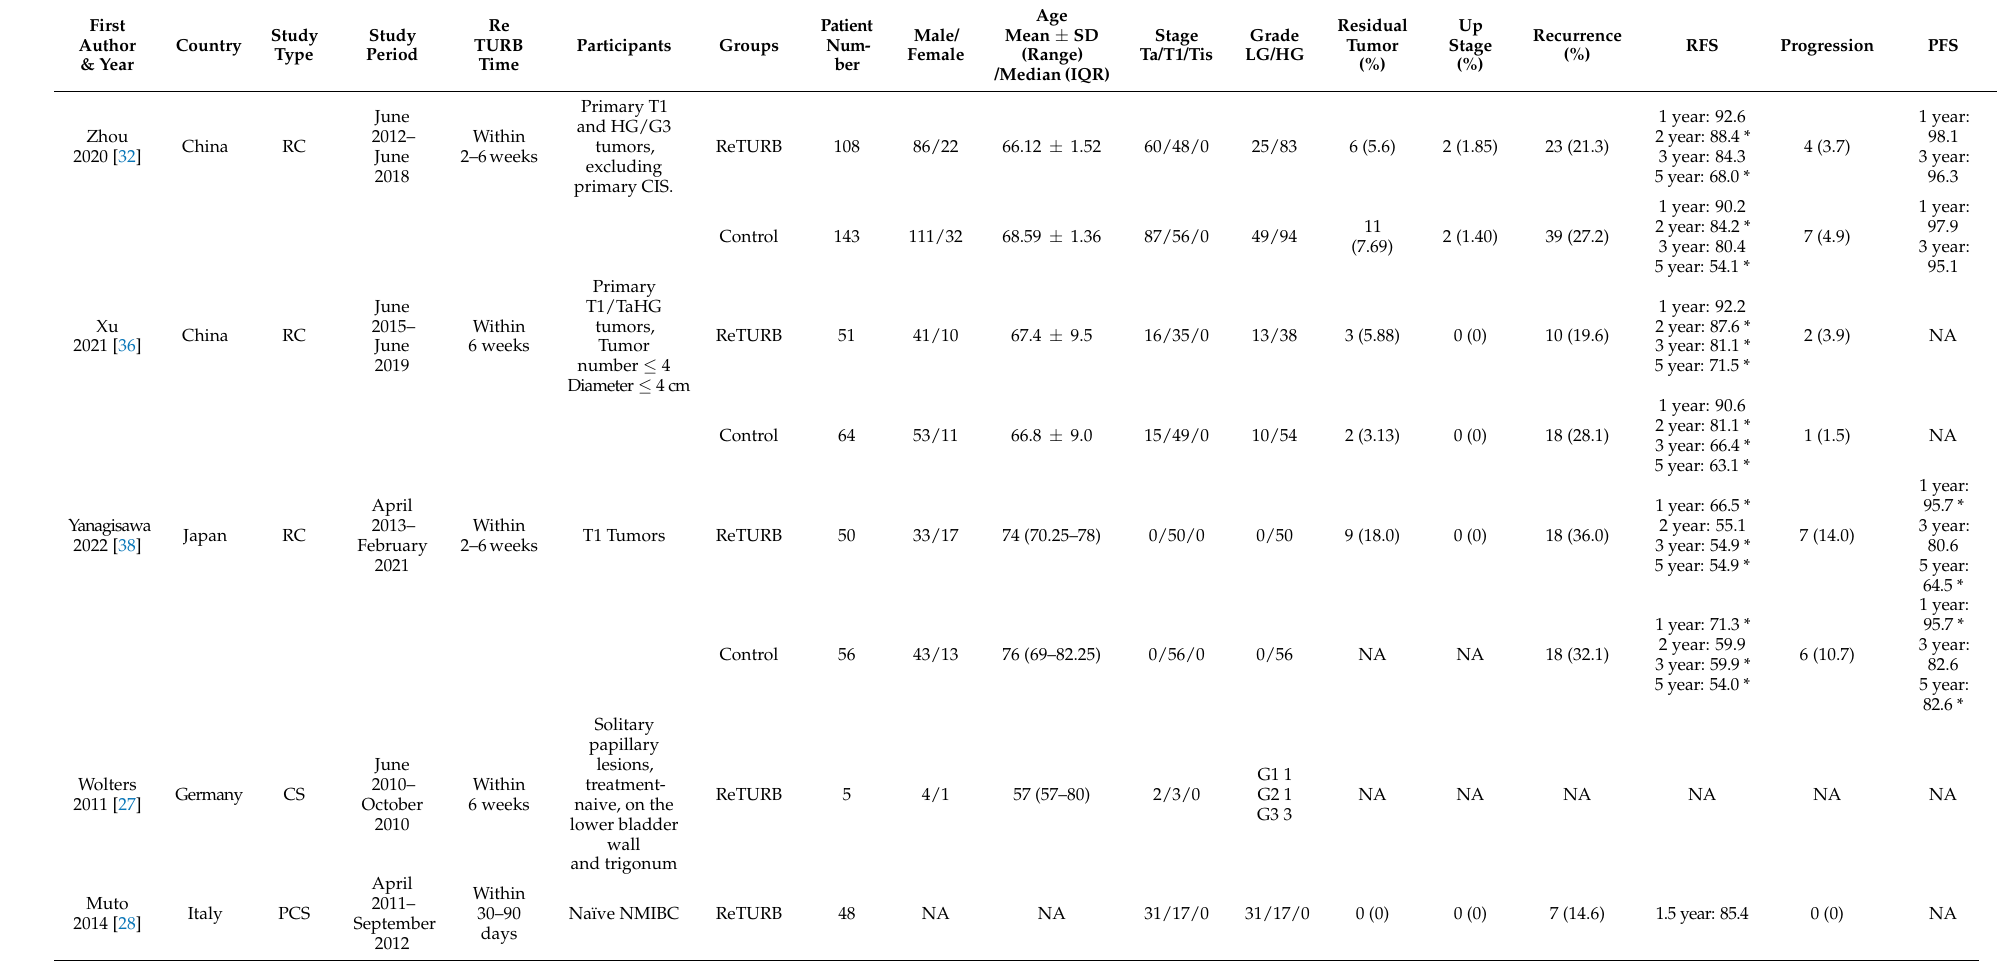
Table 2. Characteristics and outcomes of included